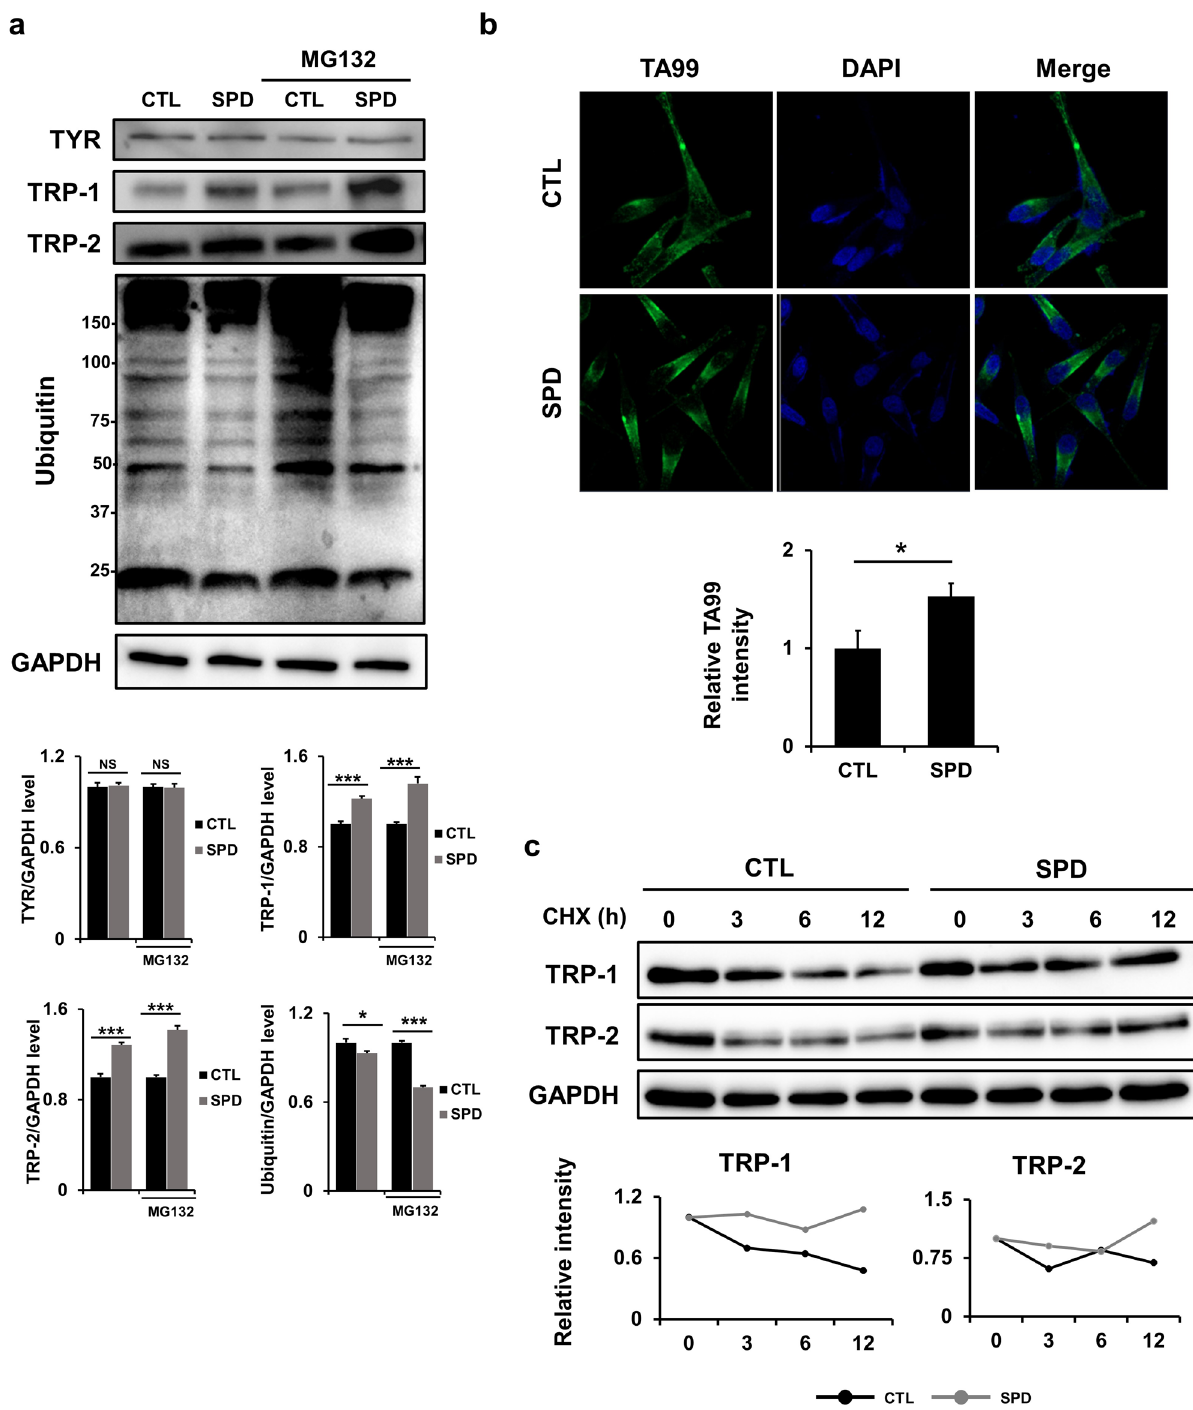
Figure 3. SPD treatment improves the stabilities of tyrosinase-related protein (TRP)-1 and TRP-2. ( a ) Western blots of B16F10 cells treated with 5 μM of SPD for 2 days and subsequent treatment with 10 μM of MG132 for 2 h. Samples were derived from the same experiment and blots were processed in parallel. Original blots are presented in Fig. S1. The data represent the results of three independent experiments. ( b ) TA99 protein levels examined by confocal microscopy at a magnification of 400× in MNT-1 cells treated with 2 μM of SPD for 10 days. Cell nuclei (blue) were stained with 4 ′ ,6-diamidino-2-phenylindole dihydrochloride (DAPI). ( c ) Western blotting of MNT-1 cells with treated with 10 μM of CHX for the indicated time periods and subsequent treatment with 2 μM of SPD. Samples were derived from the same experiment and blots were processed in parallel. Original blots are presented in Fig. S2. The data represent the results of three independent experiments. CTL: control, NS; non-significant, *P < 0.05 , **P < 0.01 , *** P <